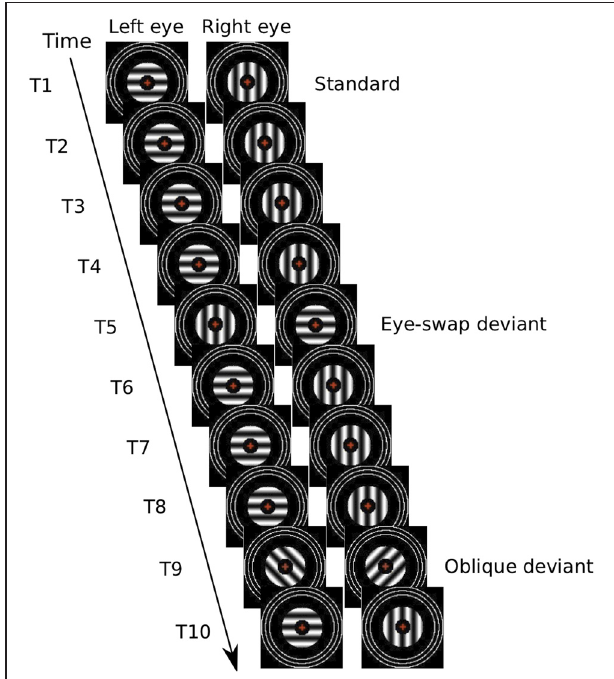
FIGURE 1 | Illustration of a possible sequence of 10 presentations of experimental stimuli. In the first (T1), the left eye views a horizontal grating and the right eye views a vertical grating for 400 ± 33ms, followed by no gratings for 100 ± 33ms. This illustrates a standard; it is repeated for four presentations (i.e., T1–T4). The fifth presentation (T5) illustrates an eye-swap deviant. This is followed by three more standards followed by an oblique deviant (T9). Then there is a final standard (T10). The red cross in the center of the stimuli represents a red number that changed every